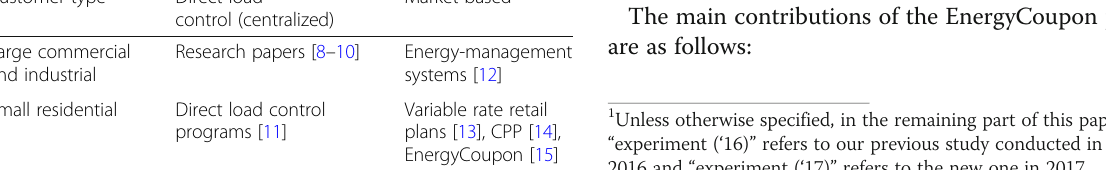
Table 1 Classification of demand response programs Customer